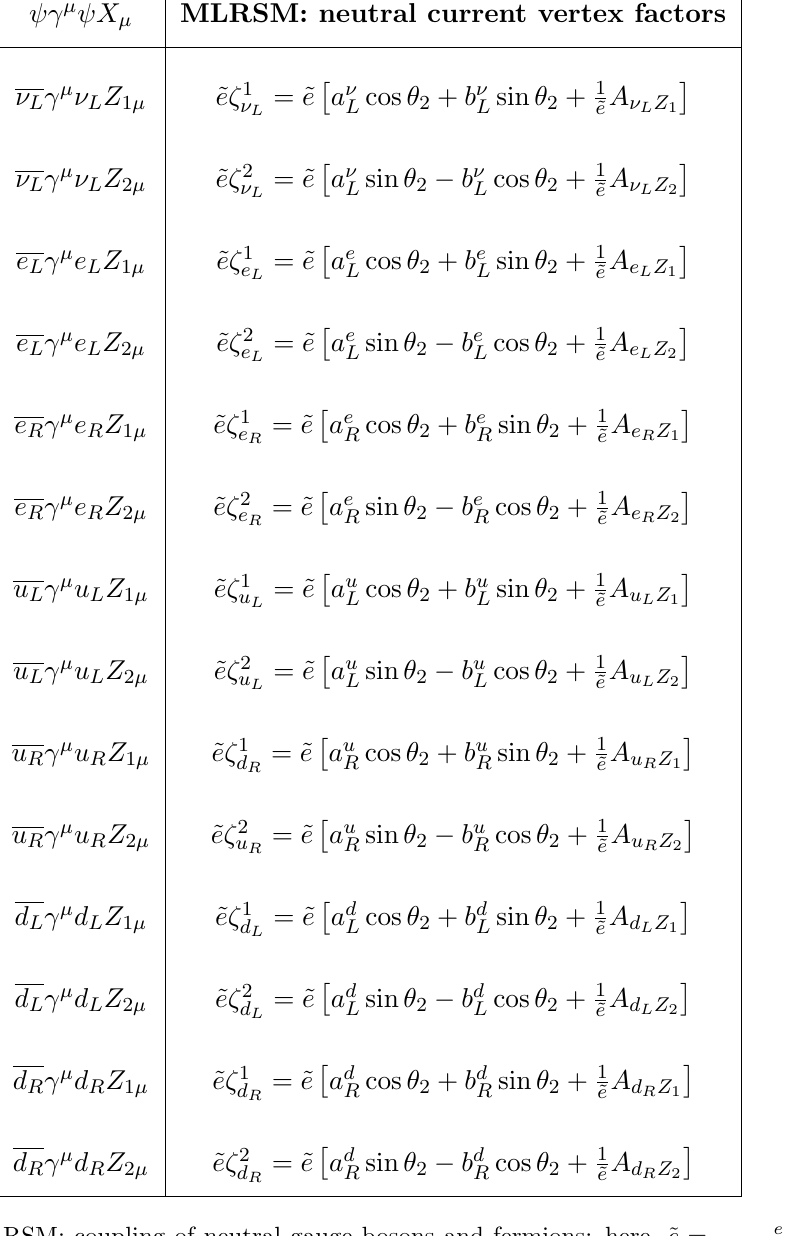
Table 32. MLRSM: coupling of neutral gauge bosons and fermions: here, ~ e = detailed structures of A ’s are mentioned in tables 33,